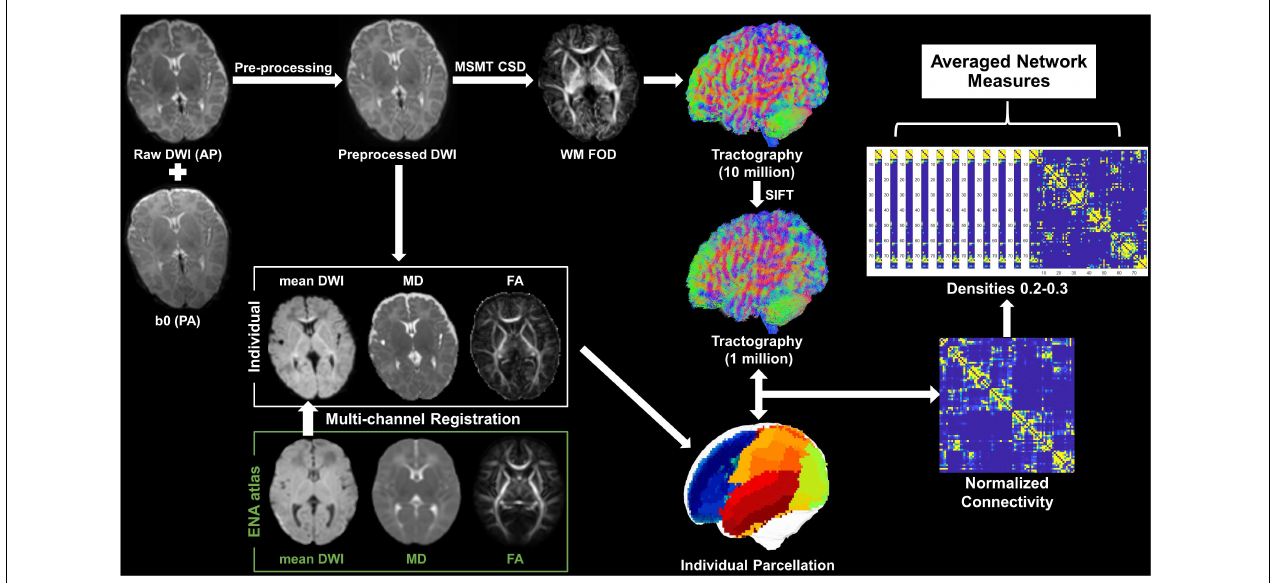
FIGURE 1 | Pipeline of data analysis. Mean DWI, MD, and FA were generated from the preprocessed dMRI and were then co-registered with the ENA atlas to obtain individual parcelation. The WM FOD was calculated according to the MSMT-CSD pipeline in MRtrix3, based on which whole-brain tractography was obtained followed by a SIFT operation. The individual parcelation and filtered tractography were used to generate a 78 × 78 symmetric connectivity matrix. Network measures were calculated at a series of network densities, and then, they were averaged for statistical analysis.